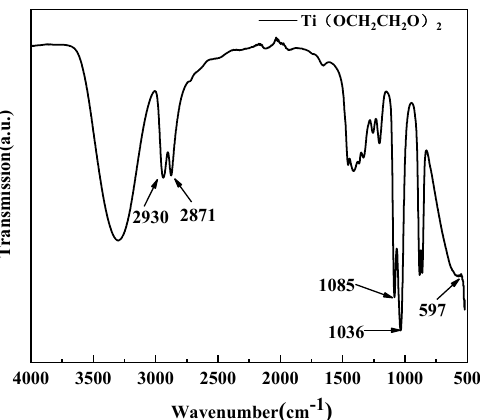
Figure 7. Infrared spectroscopy of the nano-ethylene glycol titanium catalyst.